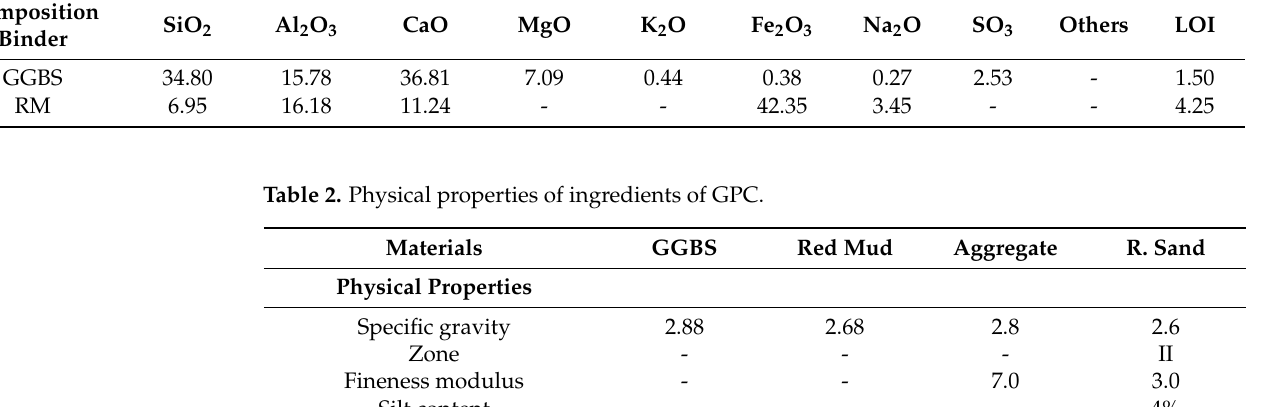
Table 1. Chemical composition of GGBS and RM.